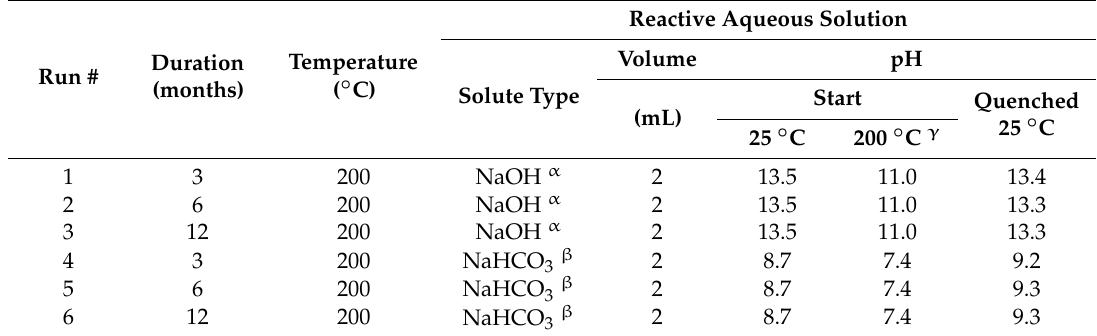
Table 1. Experimental